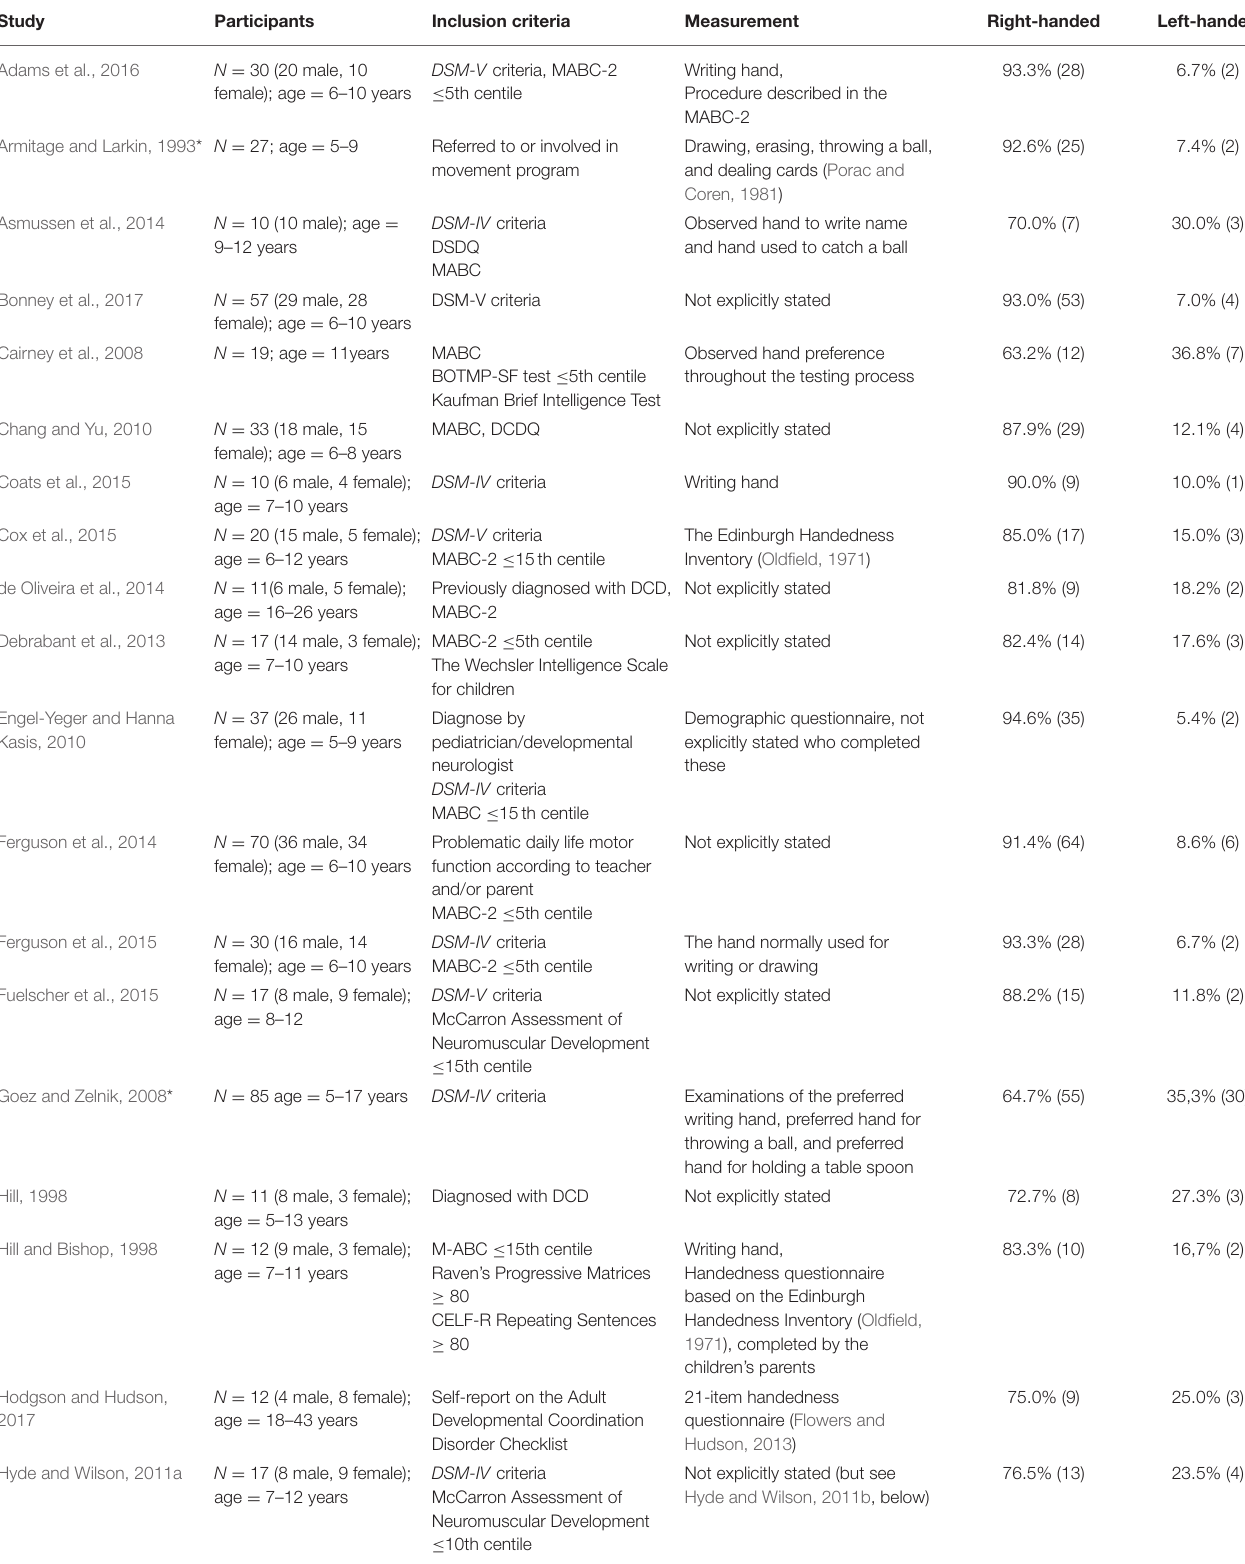
TABLE 3 | Studies reporting distributions of handedness for individuals with Developmental Coordination